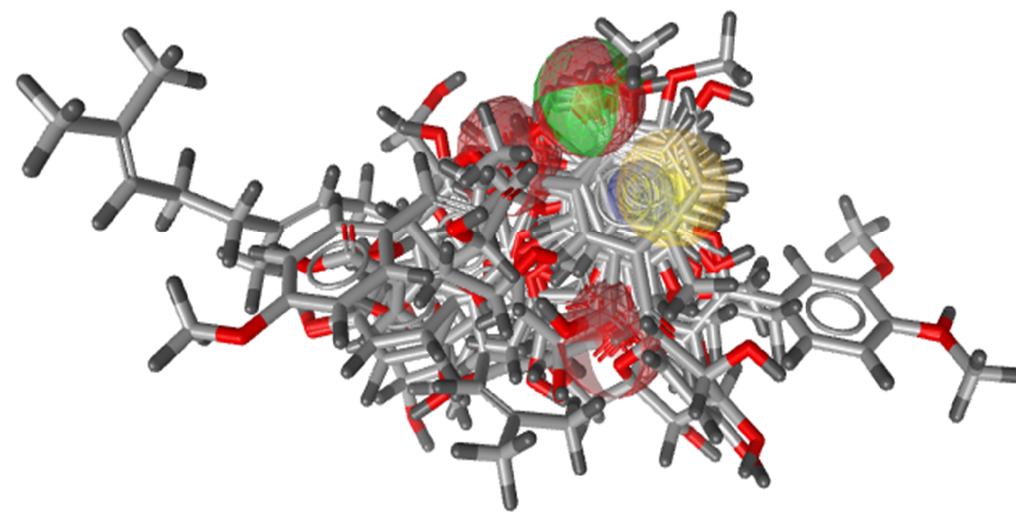
Figure 4. Visualization of hit molecules mapped onto the pharmacophore model.